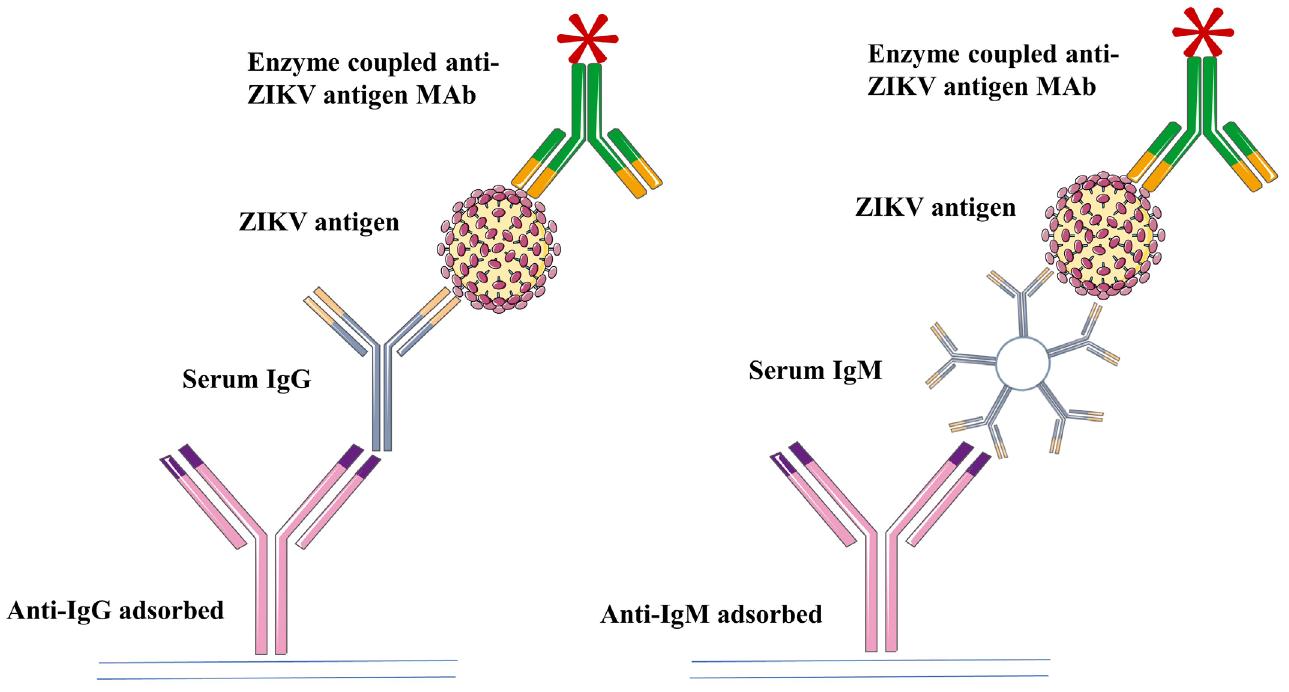
Figure 1. Schematic representation of an antibody capturing serology method for detection of IgG and IgM antibodies in serum sample using a monoclonal antibody that recognizes ZIKV